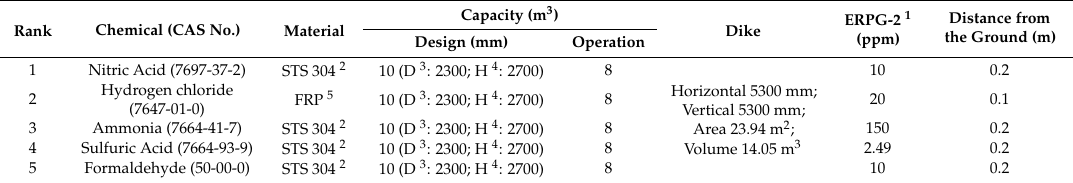
Table 2. Storage tank material and specifications for “chemicals requiring preparation for accidents”. Rank Chemical (CAS